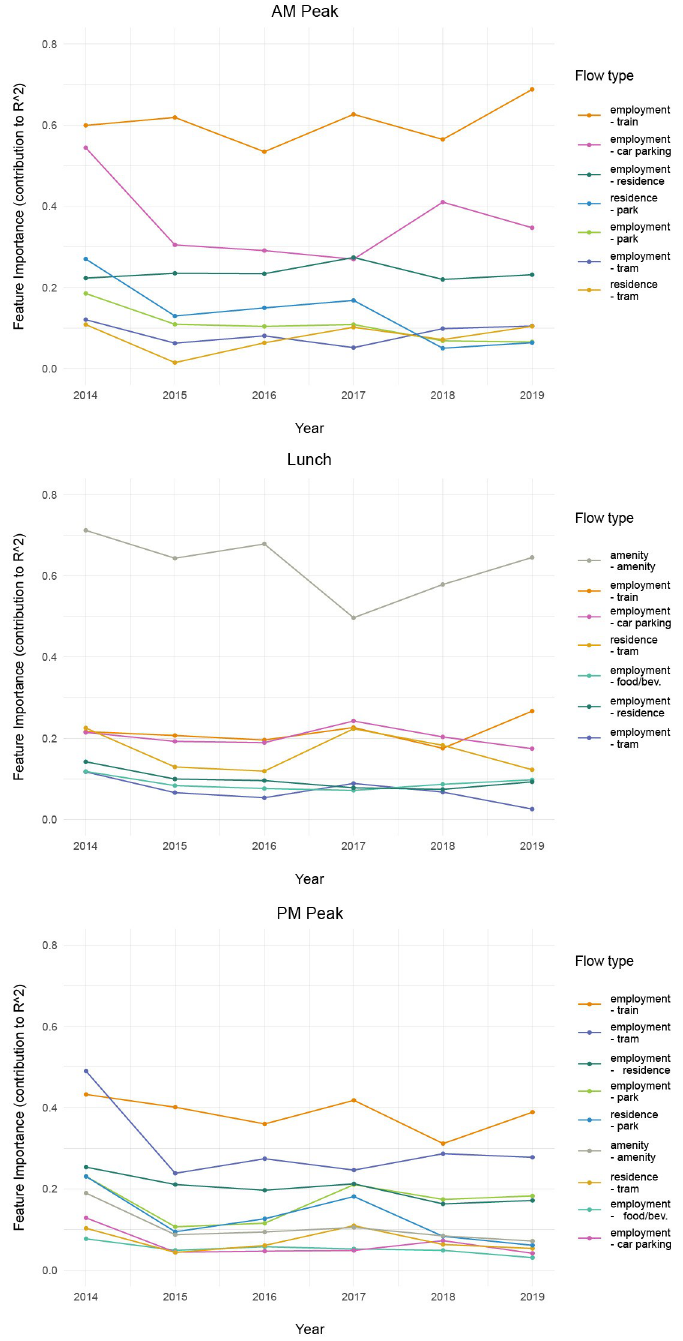
Fig 7. Stability of feature importance from 2014–2019 for AM, lunch and PM peak periods (without sensor-level dummies). During the evening peak period, employment to train and employment to tram trips domi- nate, but overall, we find a more diverse and balanced set of flows in the PM period. Significant evening flows include walks to parks and green areas, which were also present in the AM model,